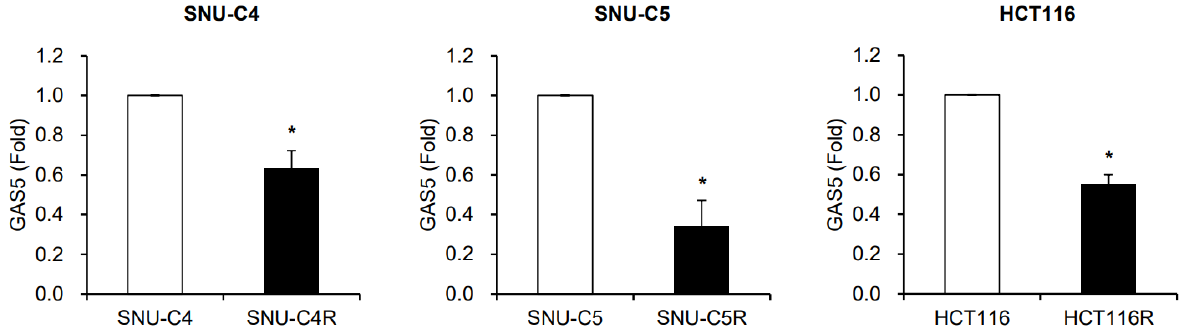
Figure 1. Downregulation of GAS5 in 5-FU resistant colon cancer cells (SNU-C4R, SNU-C5R and HCT116R) compared to their parental cells (SNU-C4, SNU-C5, and HCT116). Relative levels of GAS5 were determined between parental cells and resistant cells by RT-qPCR. GAPDH mRNA level was used for normalization. Data were expressed as the mean ± SEM from three independent experiments. The s tatistical significance of the data was analyzed via Student’s t -test; *, p < 0.05.